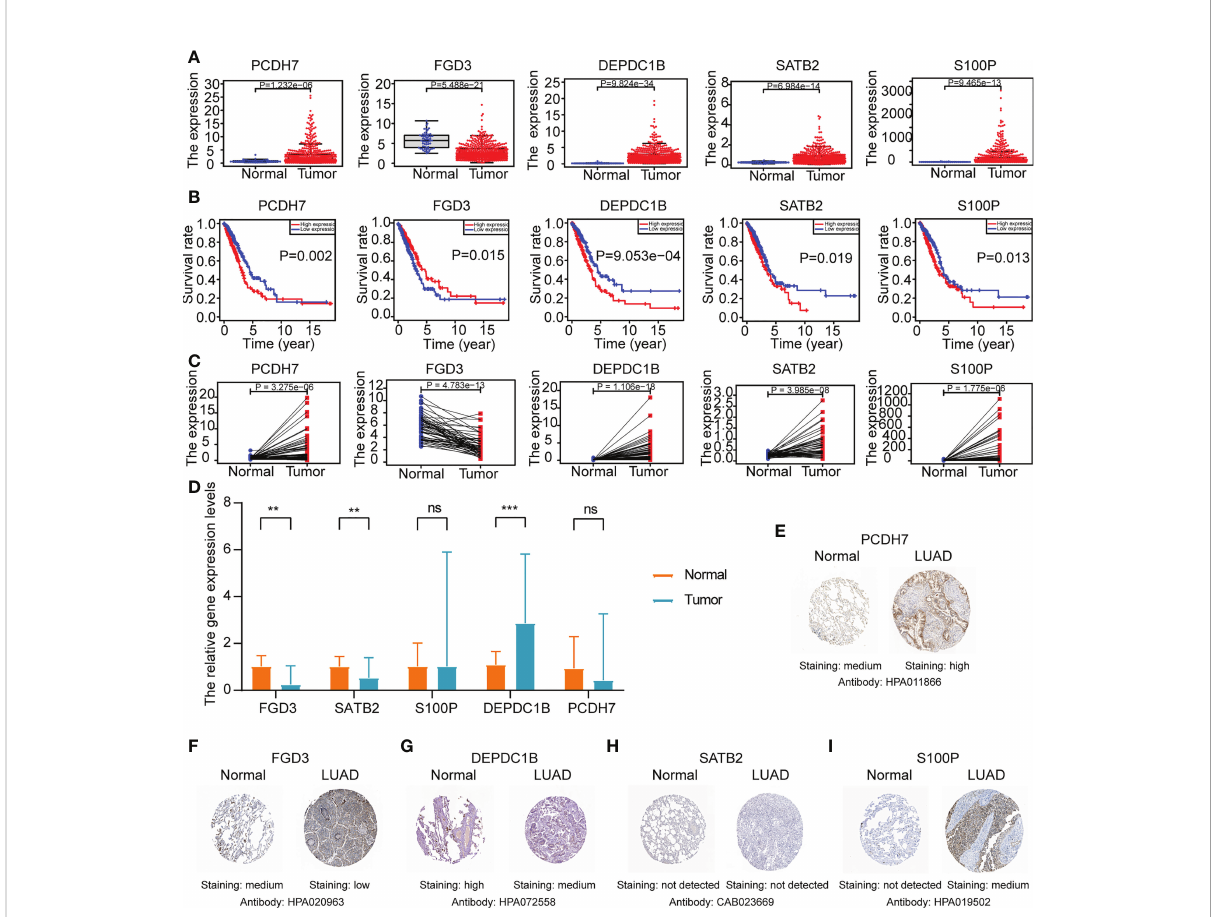
FIGURE 11 The gene expression levels of ERS (FGD3, PCDH7, DEPDC1B, SATB2, and S100P) in normal and LUAD tissues. (A) The gene expression level analyses of ERS in normal and LUAD tissues of TCGA-LUAD cohort. (B) The survival rate analyses of ERS in TCGA-LUAD patients. (C) The gene expression level analyses of ERS in paired lung cancer tissue and adjacent normal tissue of TCGA-LUAD cohort. (D) Relative mRNA expression levels of ERS in normal and LUAD tissues through qRT-PCR analysis (*P<0.05, **P<0.01, and ***P<0.001). (E – I) Representative Immunohistochemistry images of ERS in normal lung tissue and LUAD tissue from the HPA